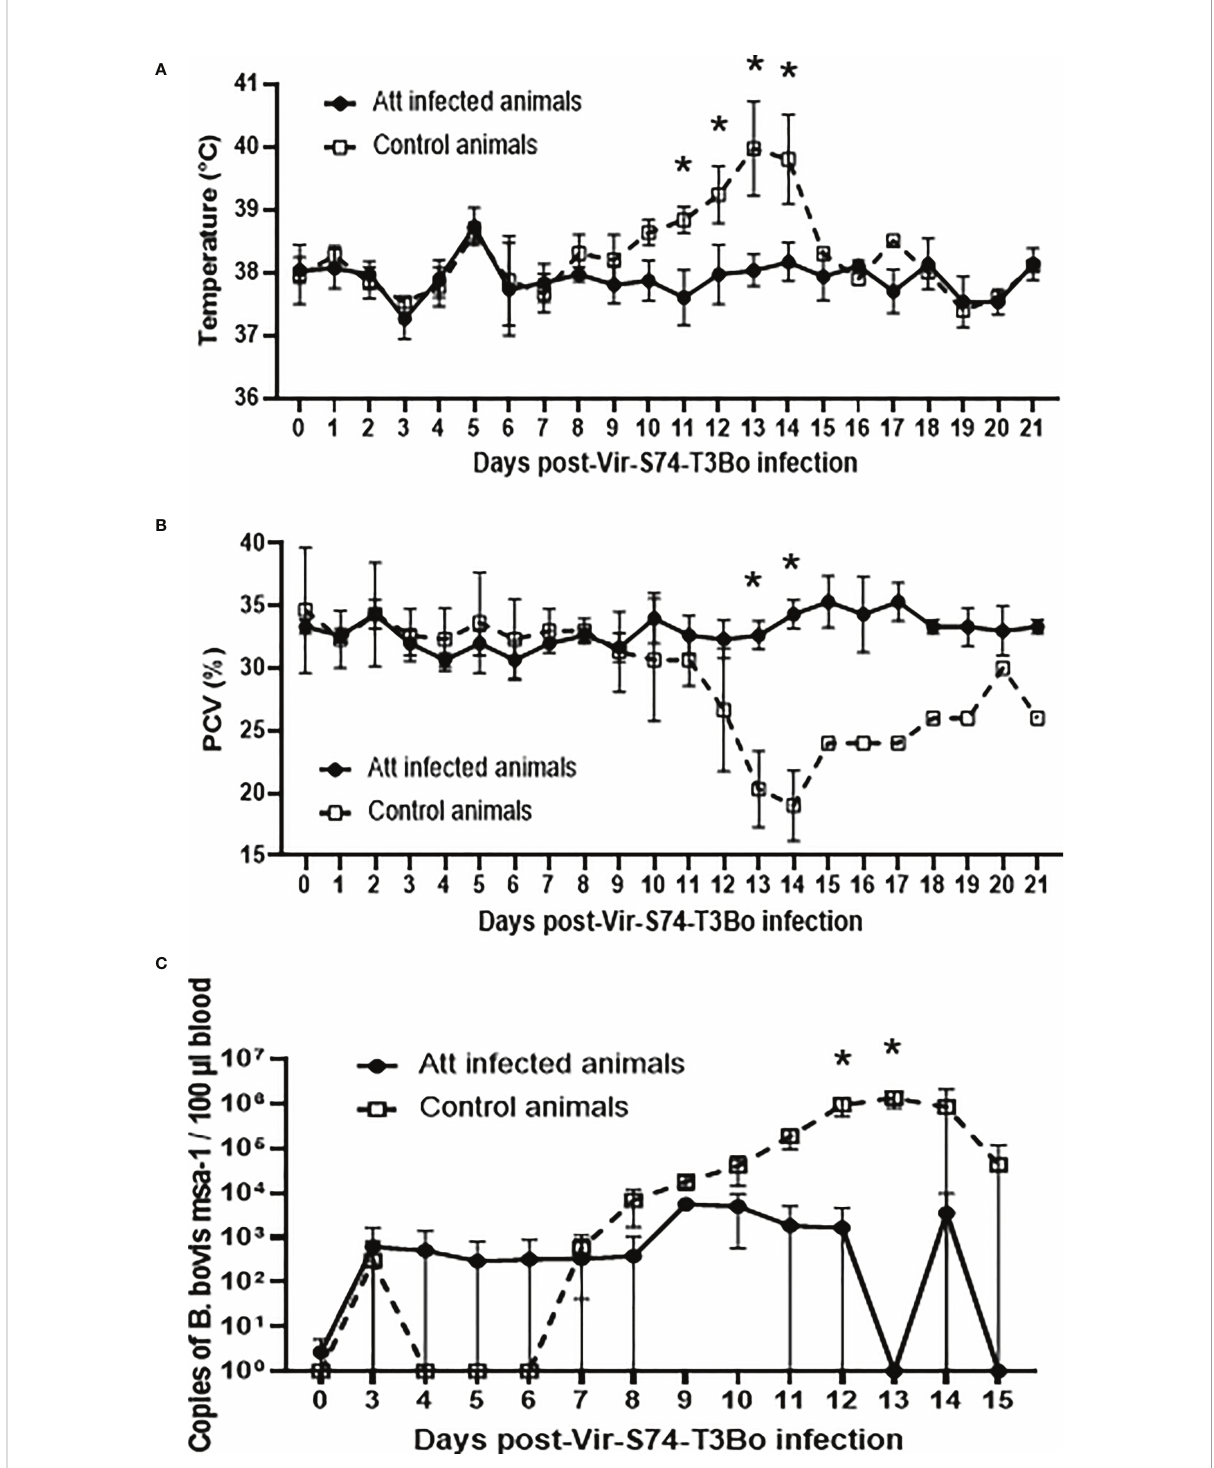
FIGURE 2 Temperature (A) , packed cell volume (PCV) (B) , and B. bovis load in peripheral blood accessed by real-time quantitative PCR (C) after infection with the virulent B bovis strain Vir-S74-T3Bo. Att infected animals (n=3). Control animals (n=3; two animals of the control group were humanely euthanized at days 13 and 14 after Vir-S74-T3Bo inoculation due to the severity of the disease). *